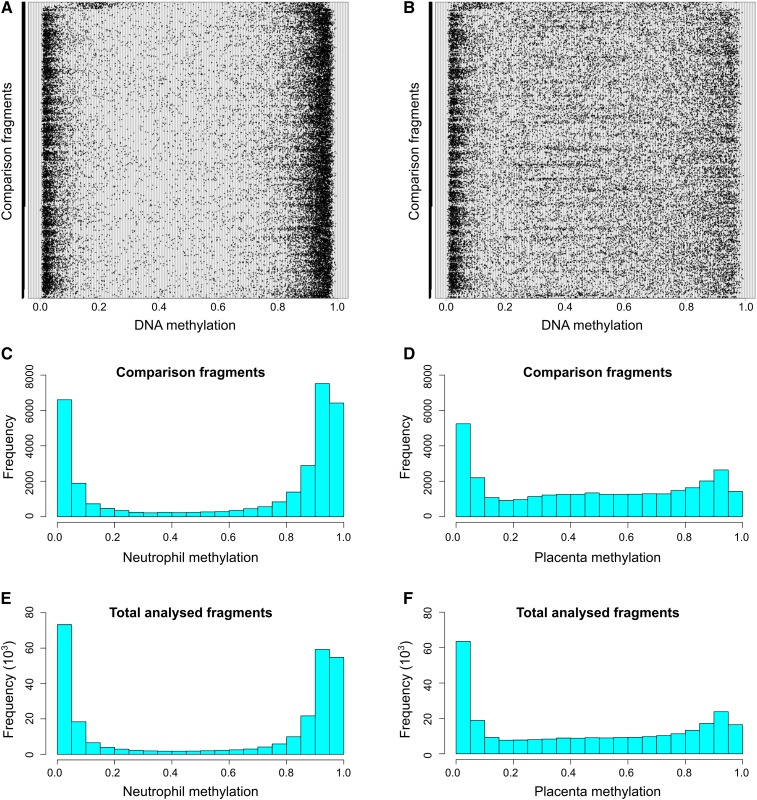
Methylation in placentas and neutrophils. The mean methylation of each of 32,163 comparison fragments from chromosome 1 (bottom) to chromosome X in neutrophils (A) and placenta (B). (C) and (D) Histograms of the data shown in (A) and (B). (E) and (F) Histograms of 279,762 MspI fragments (total analyzed fragments).